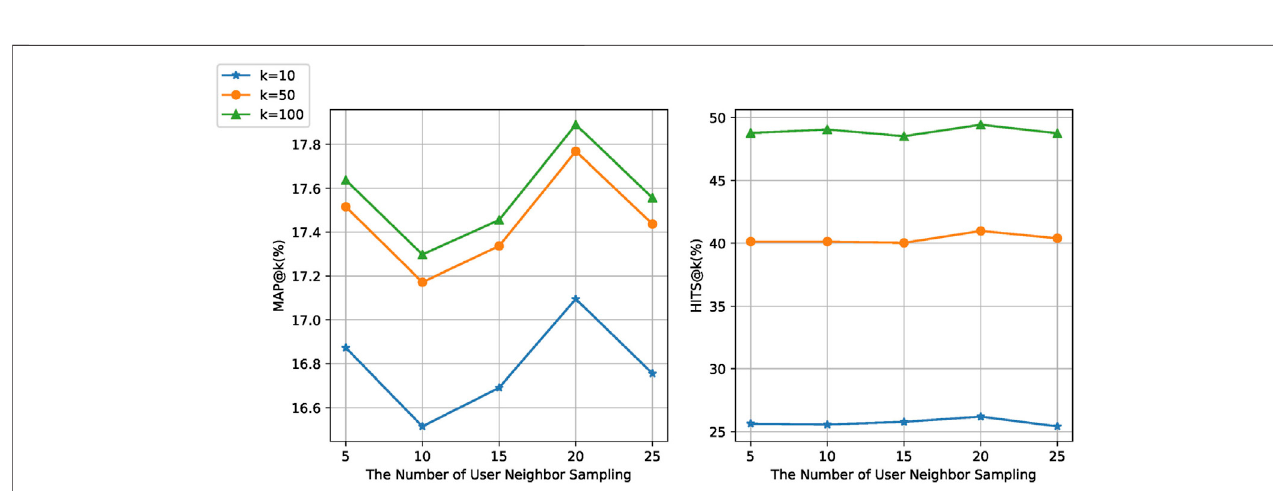
FIGURE 6 | The in fl uence of number of user neighbor sampling on the metrics of MAP@k and HITS@k.